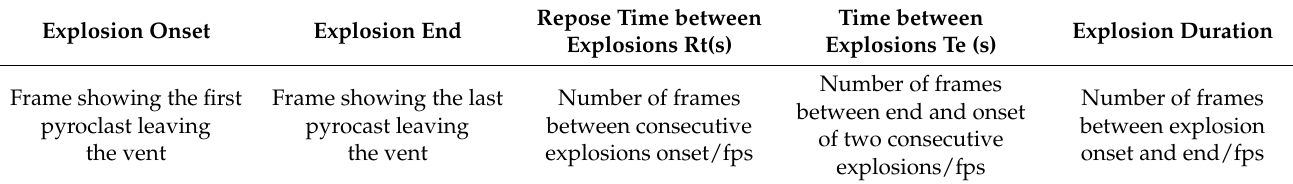
Table 2. Criteria for calculating temporal parameters from